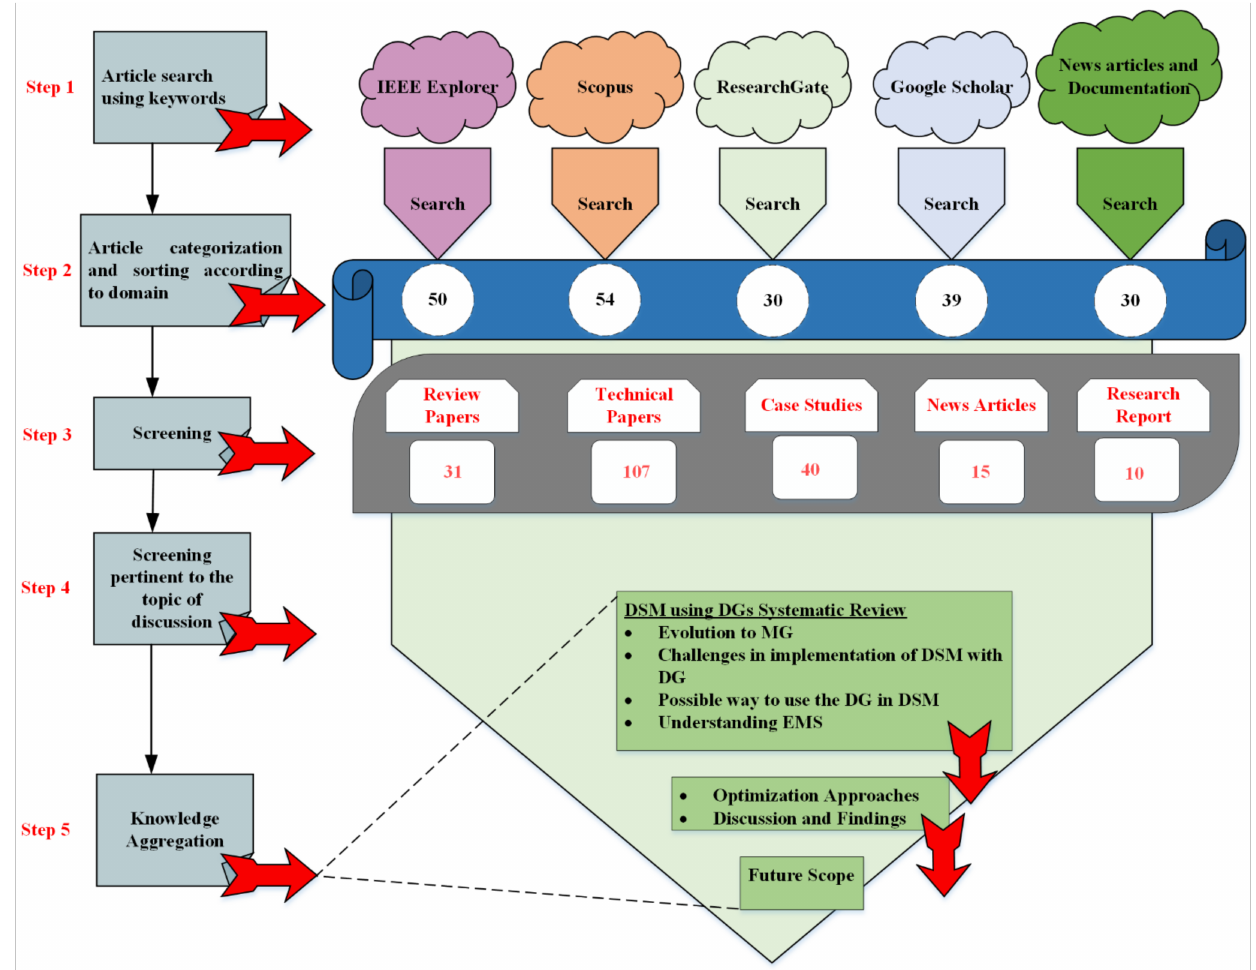
Figure 1. Review methodology for this